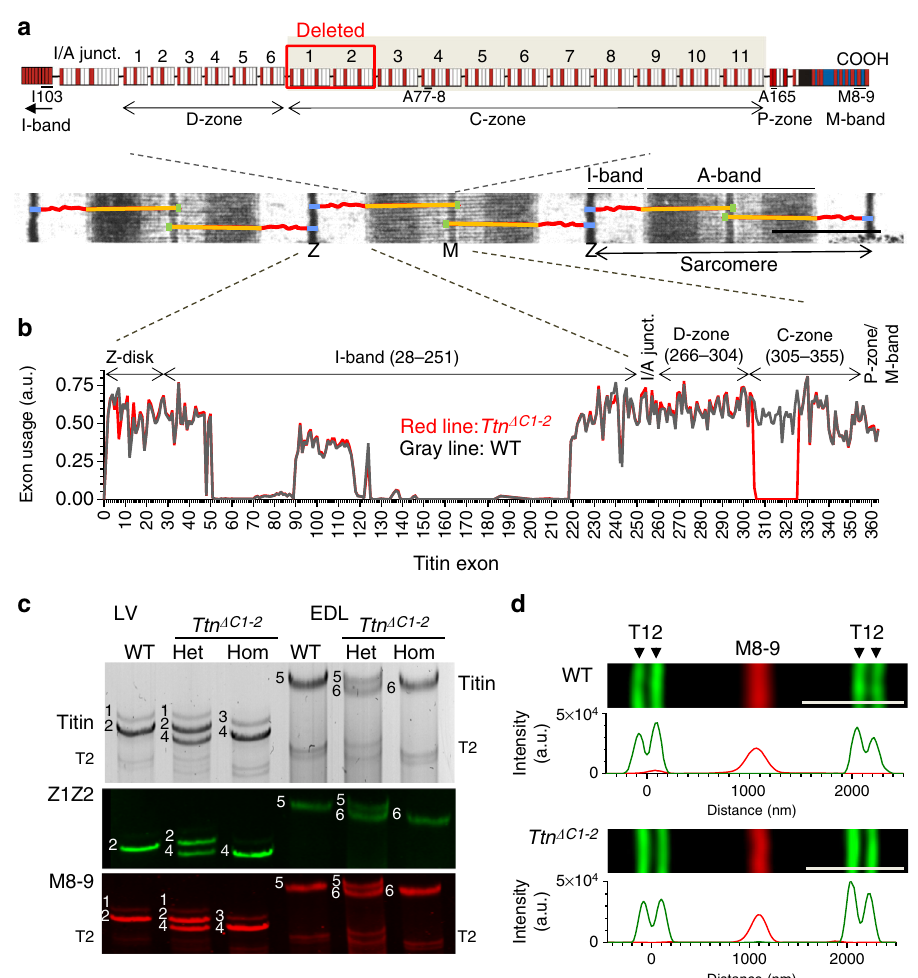
Fig. 1 Genetically engineered mouse model lacking two C-zone repeats in titin. a Titin spans from Z-disk (Z) to M-band (M) in the sarcomere. Top, domain